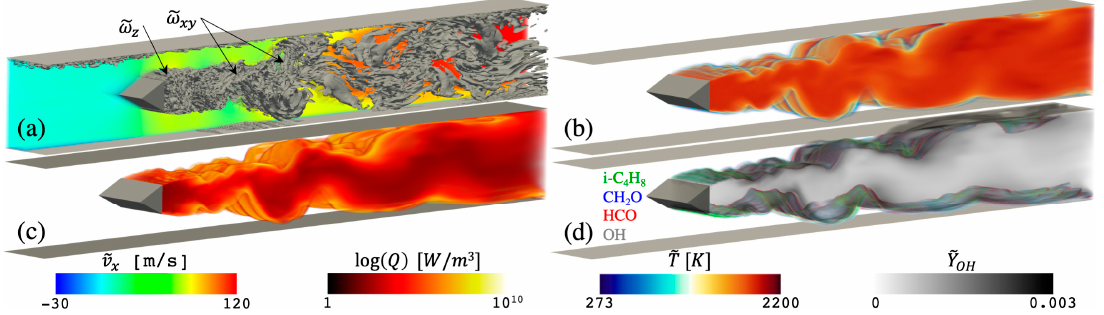
Figure 4. Instantaneous perspective views from the side of the reacting flow in the AFRL equilateral triangular bluff-body combustor in terms of ( a ) volume renderings of the axial velocity, 𝑣(cid:3556) (cid:3051) , and an iso-surface of the second invariant of the velocity gradient tensor, 𝜆 (cid:2870) , ( b ) temperature, 𝑇(cid:3560) , ( c ) heat release, log(𝑄) , and ( d ) mass fractions, 𝑌(cid:3560) (cid:3036) , of i-C 4 H 8 , CH 2 O, HCO, and OH for C1.